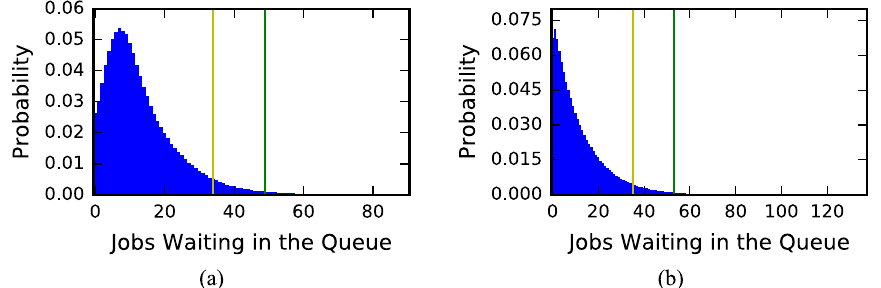
Figure 20. Normalized histogram plot of the discrete-event simulation of queue occupancy. This is for two sets of parameters with Poisson arrivals. The 95th percentile is marked with the yellow vertical line and the 99th percentile is marked with the green vertical line. ( a ) C = 10, N = 100,